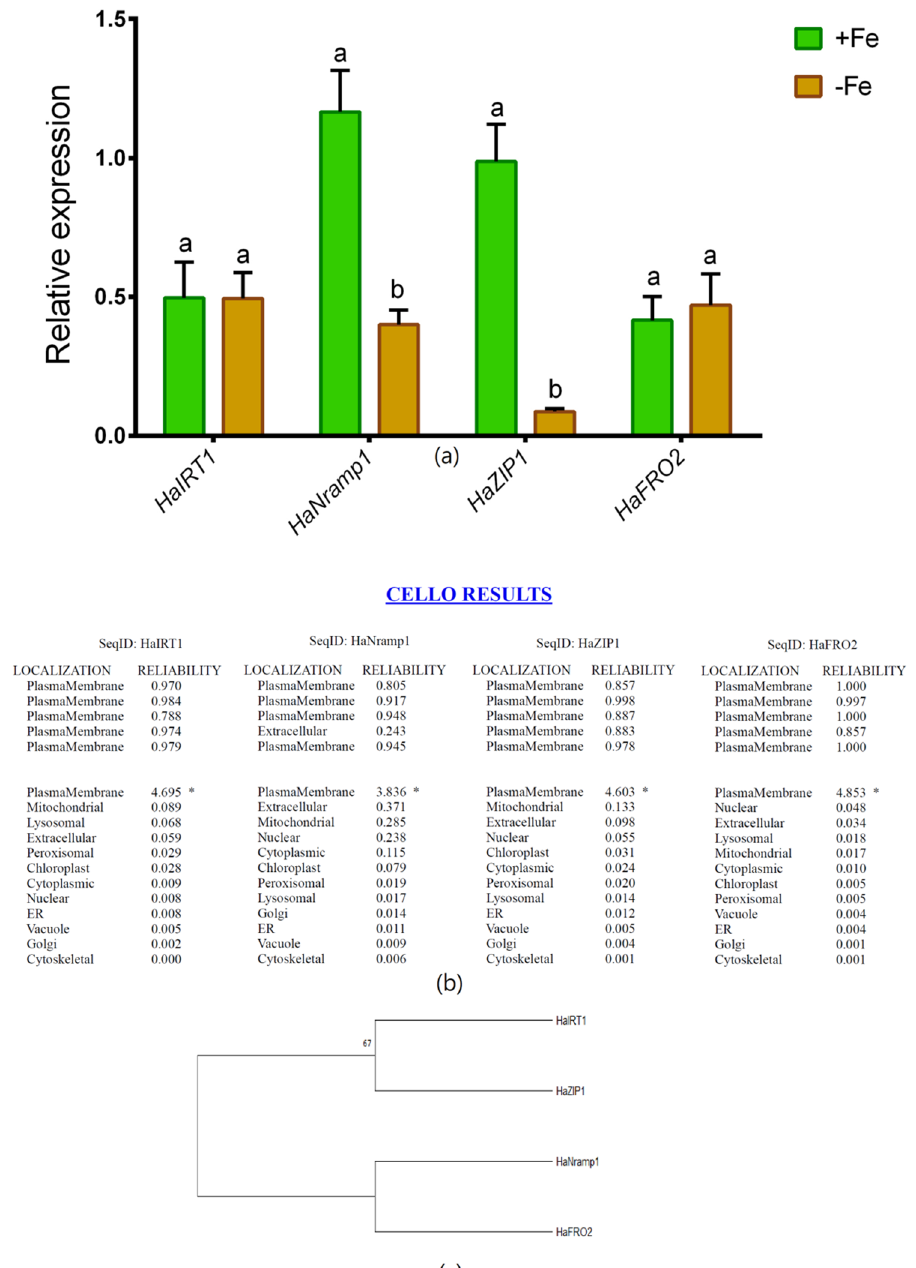
Figure 3. Quantitative expression ( a ), CELLO subcellular localization prediction ( b ) and phylogenetic tree of Fe-related genes ( c ) in roots of sunflower cultivated under Fe-sufficient and Fe-deficient conditions. Different letters in each column indicate significant differences between means ± SD of treatments (n = 3) at a P < 0.05 significance level. Trees were constructed by MEGA 6 software with the maximum likelihood (ML) method for 100 bootstrap